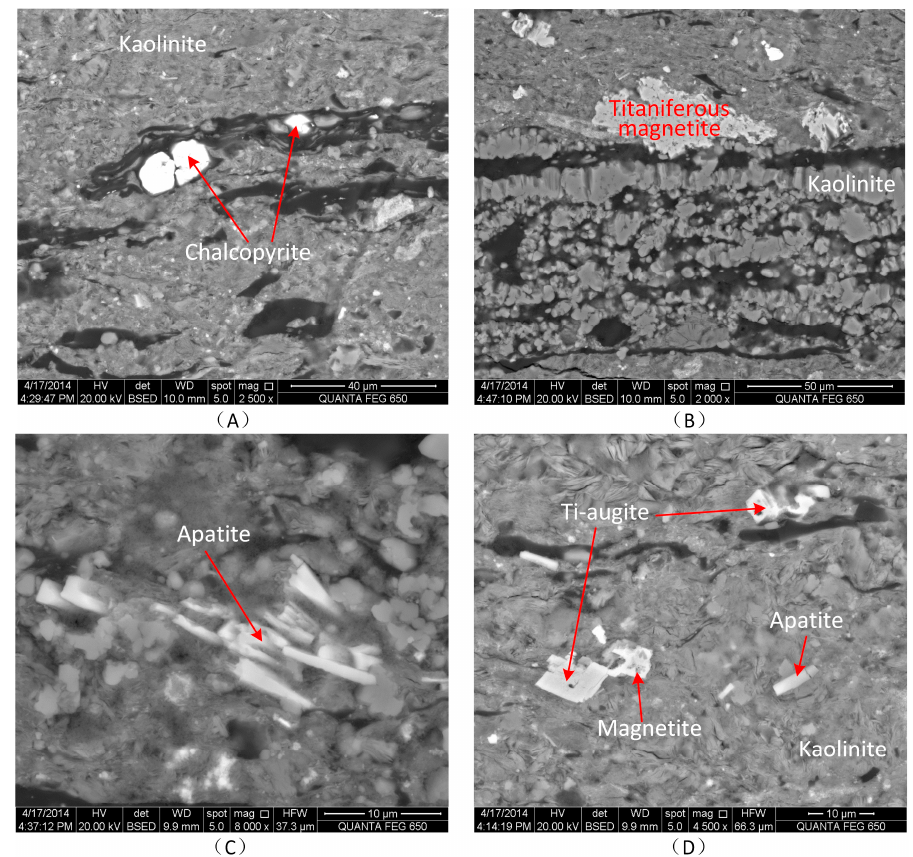
Figure 9. SEM back-scattered electron images of ( A ) fracture-filling chalcopyrite; ( B ) irregular granular of titaniferous magnetite and a vermicular texture in the kaolinite; ( C ) acicular idiomorphic crystals of apatite; and ( D ) phenocrysts of Ti-augite in C19-r.